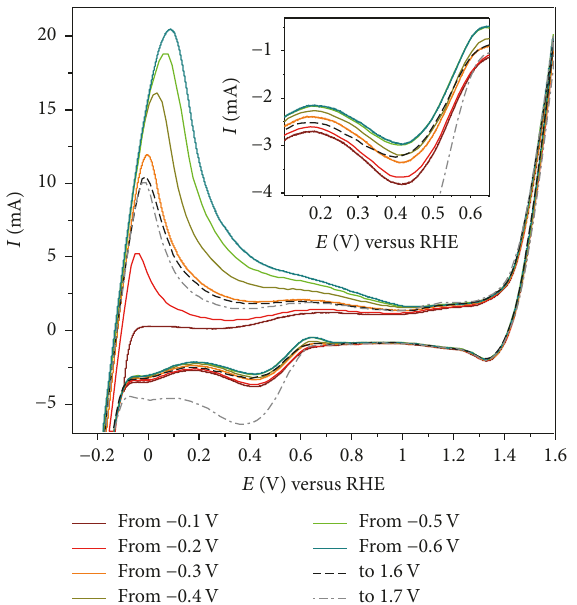
Figure 6: Increasing oxidation of adsorbed hydrogen (by hydrogen insertion into bulk RuO 2 ) in a more and more cathodic potential window (hydrogen evolution) and more positive potentials (oxygen evolution). Picture inside: Ru(IV) → Ru(III) reduction at 0.4 V.